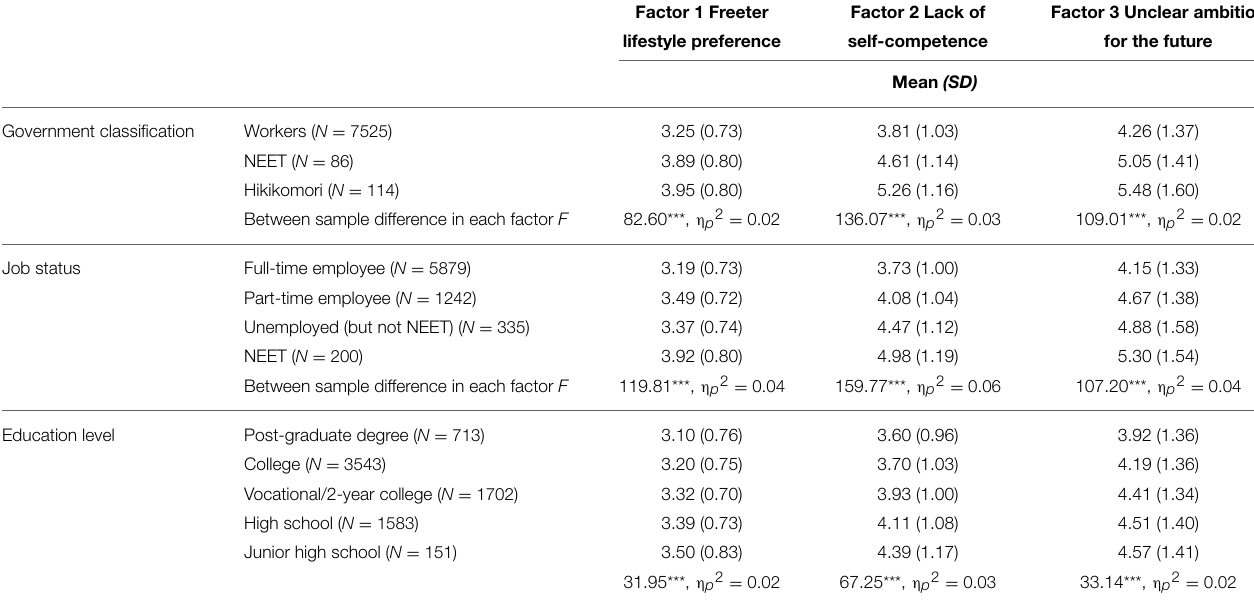
TABLE 2 | Mean scores across demographic factors (Study